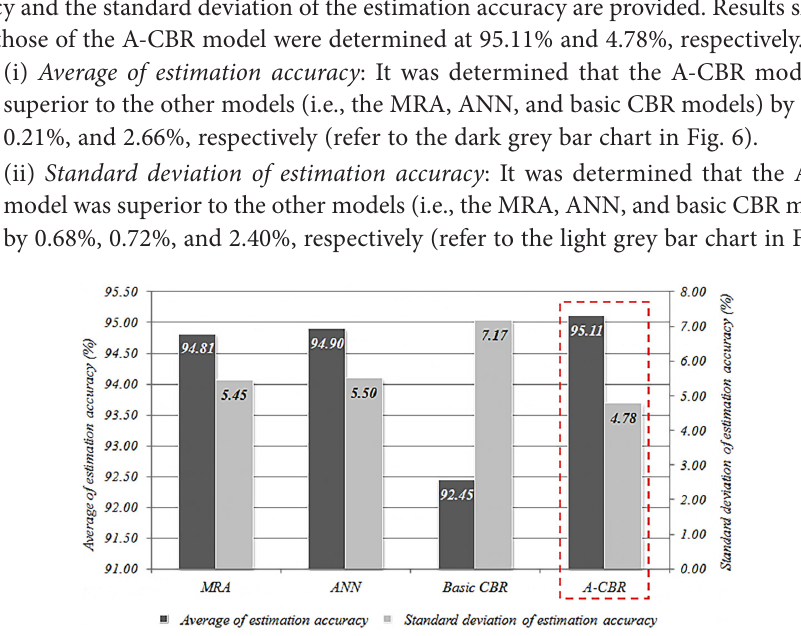
Fig. 6. Comparison of the estimation accuracy by